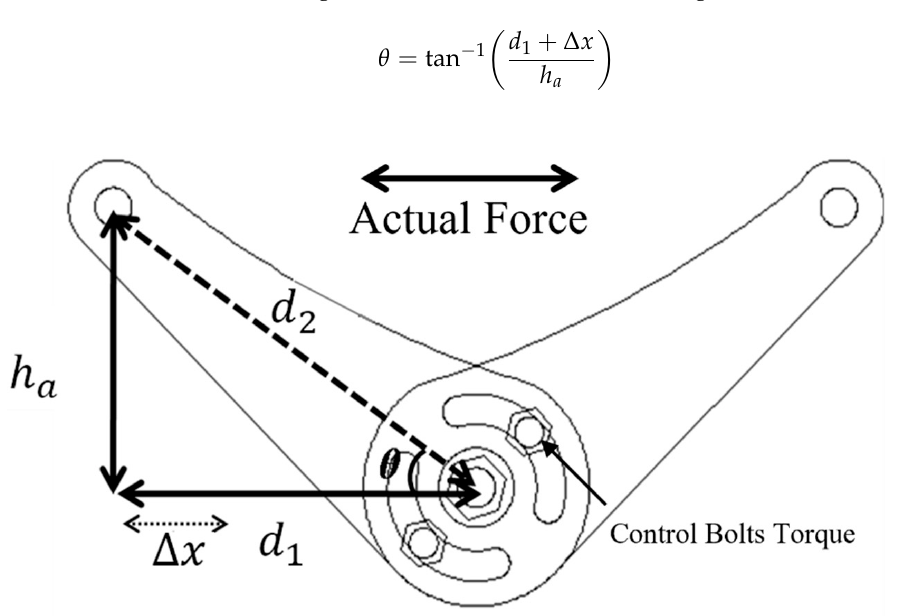
Figure 19. Principle of Rotary Type Friction Damper.